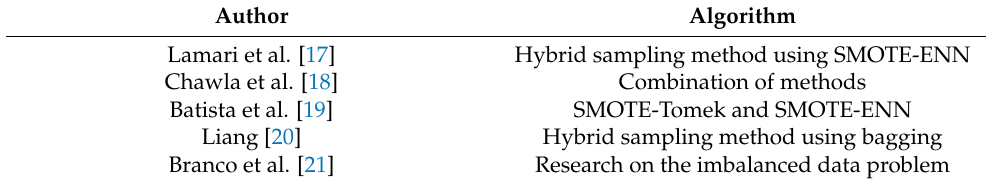
Table 2. Summary of the literature